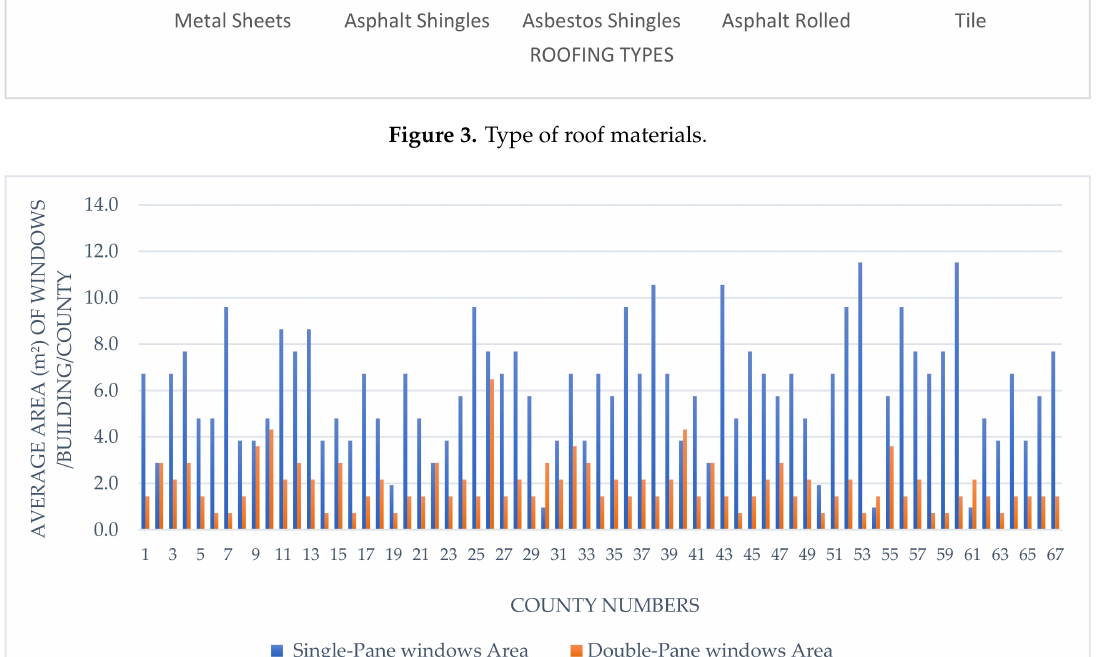
Figure 4. Per unit area of windows and types for selected buildings in each county.